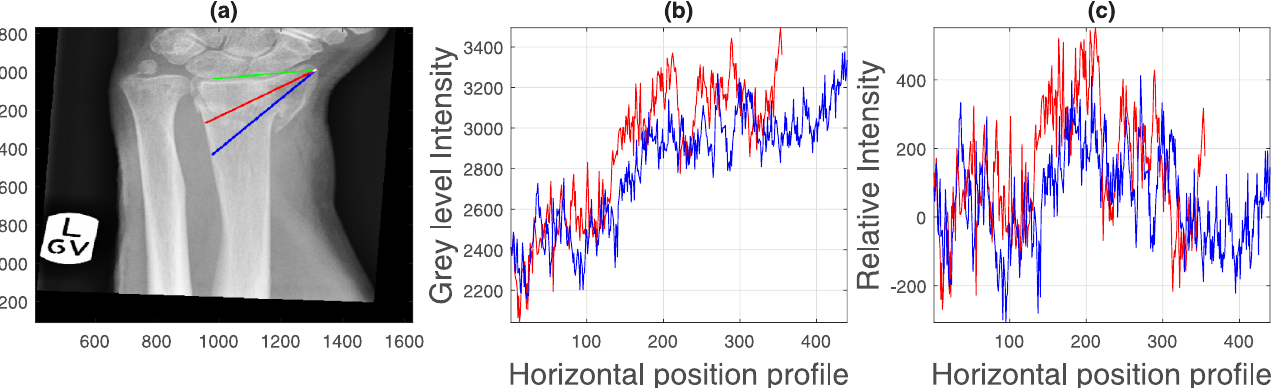
Fig 9. Semi-automatic extraction of texture measurements from intensity profiles. (a) Profile lines from the radial styloid. Initially, a line (green) is automatically traced between the lunate (red in Fig 5a) the radial styloid (green in Fig 5a) landmarks. Two lines are automatically derived from the first, one at 30 degrees (red) and one at 45 degrees (blue) from the radial styloid up to the edge of the radius, which is automatically detected. (b) Intensity profiles corresponding to the lines traced in (a). Notice the increasing slope. (c) Intensity profiles adjusted by removing the slope.